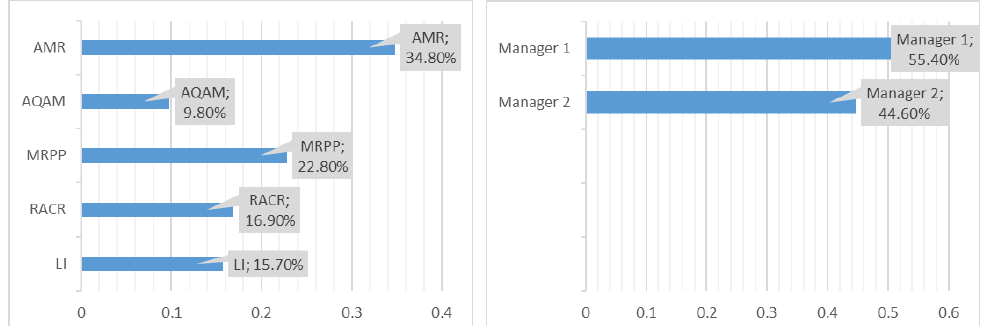
Figure 7. Scenario 5 (own processing).